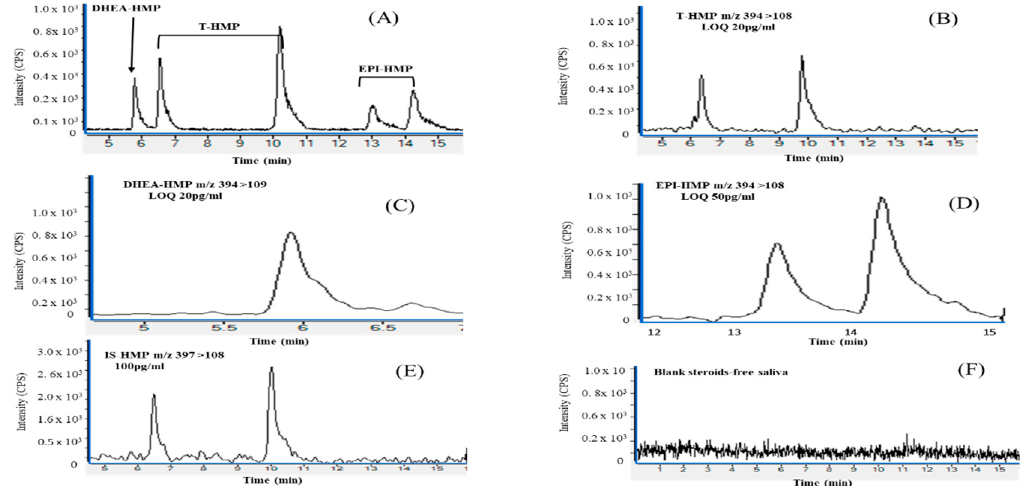
Figure 1. Chromatograms of HMP derivatives of testosterone (T-HMP), dehydroepiandrosterone (DHEA-HMP), epitestosterone (EPI-HMP) and Testosterone-d 3 HMP (T-d 3 -HMP) in healthy human saliva spiked after treatment with activated charcoal: ( A ) chromatographic resolution of derivative testosterone (T), dehydroepiandrosterone (DHEA) and epitestosterone (EPI), (400 pg / mL) spiked in steroid free saliva. ( B ) T-HMP multiple reaction monitoring (MRM) illustrating low limit of quantification (LOQ) m / z 394 > 108, (20 pg / mL); ( C ) DHEA-HMP limit of quantification (LOQ) m / z 394 > 109, (20 pg / mL); ( D ) EPI-HMP limit of quantification (LOQ) m / z 394 > 108, (50 pg / mL); ( E ) Testosterone-d 3 HMP m / z 397 > 108, (100 pg / mL); (F) Blank: saliva treated with activated charcoal, before being extracted and derivatized. The liquid chromatography-mass spectrometry (LC-MS/MS) conditions are described in section 2.3.2. Counts per second (cps).